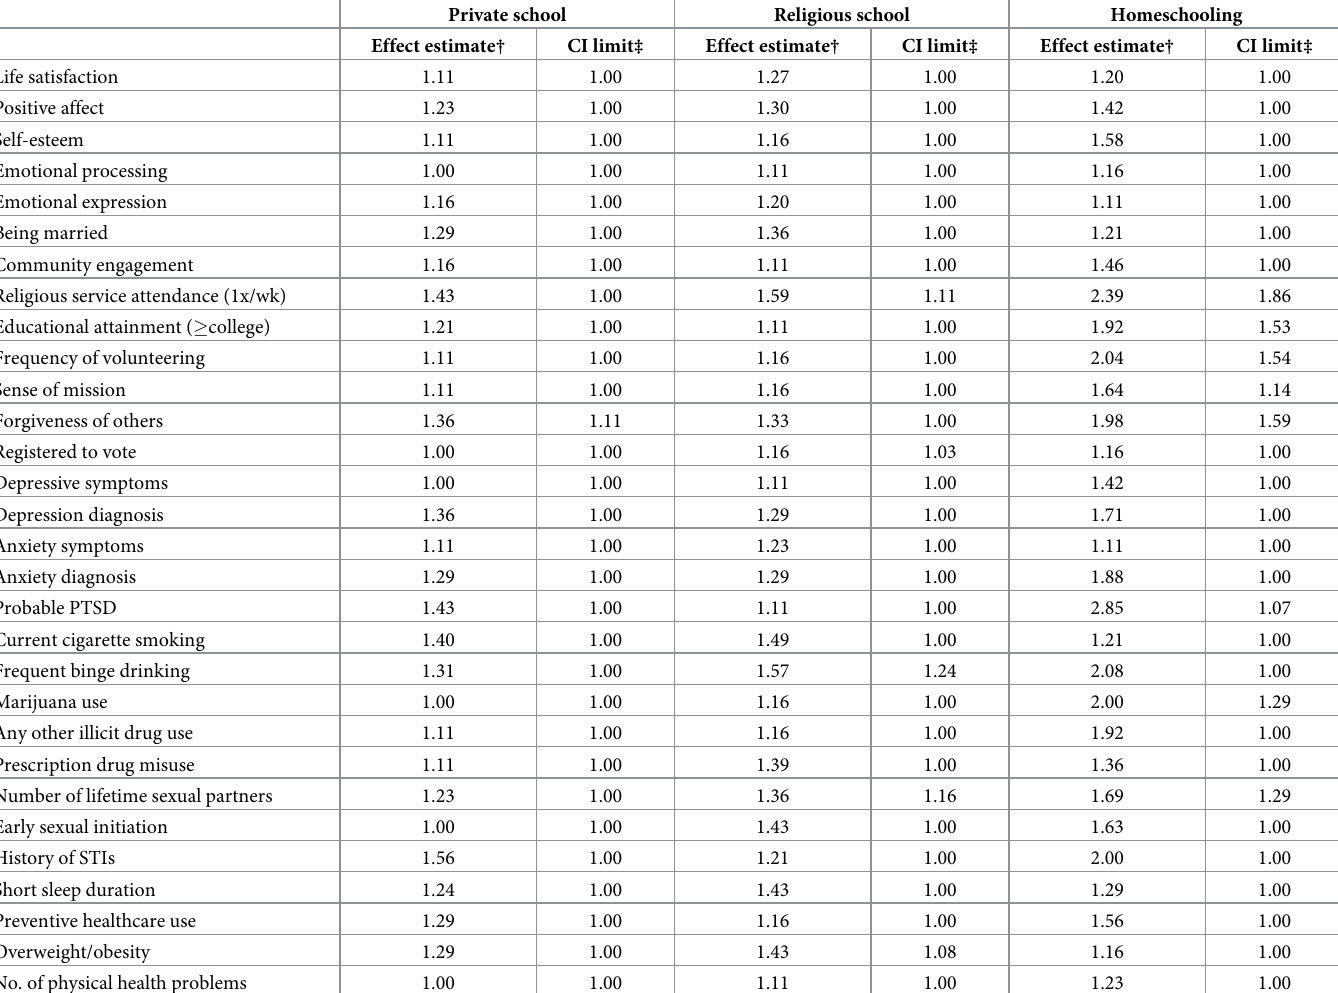
Table 3. Robustness to unmeasured confounding (E-values � ) for the associations between school types and subsequent health and well-being (Growing Up Today Study [GUTS] from 1999 to 2007, 2010 or 2013 questionnaire wave, N =